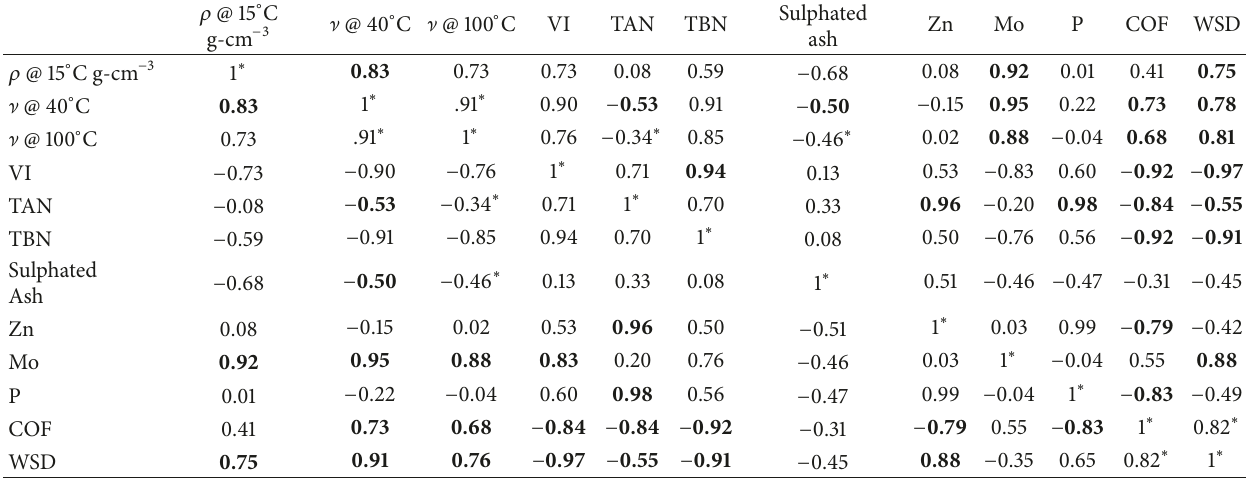
Table 7: Correlation coefficient matrix for lubricant properties (physicochemical and tribological).